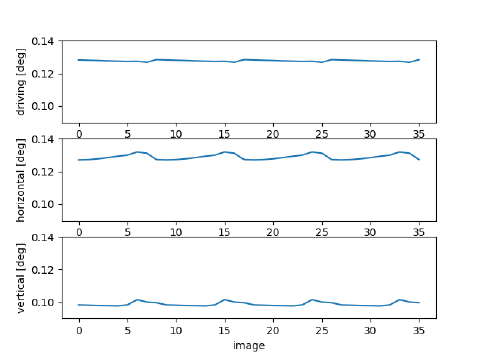
Figure 2. The camera trajectory and the placement of the GCPs for testing the static setup.